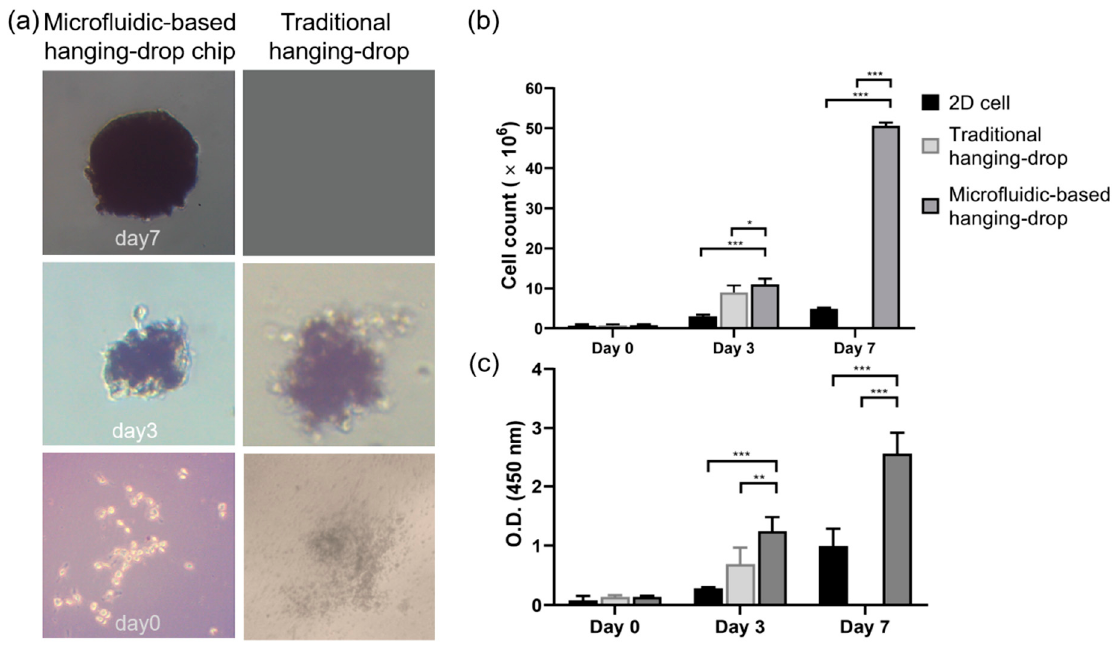
Figure 6. ( a ) Spheroid formation in two kinds of hanging drop methods, ( b ) cell proliferation assay; and ( c ) evaluation of cell activity by BrdU assay; *, p < 0.05; **, p < 0.01; ***, p <